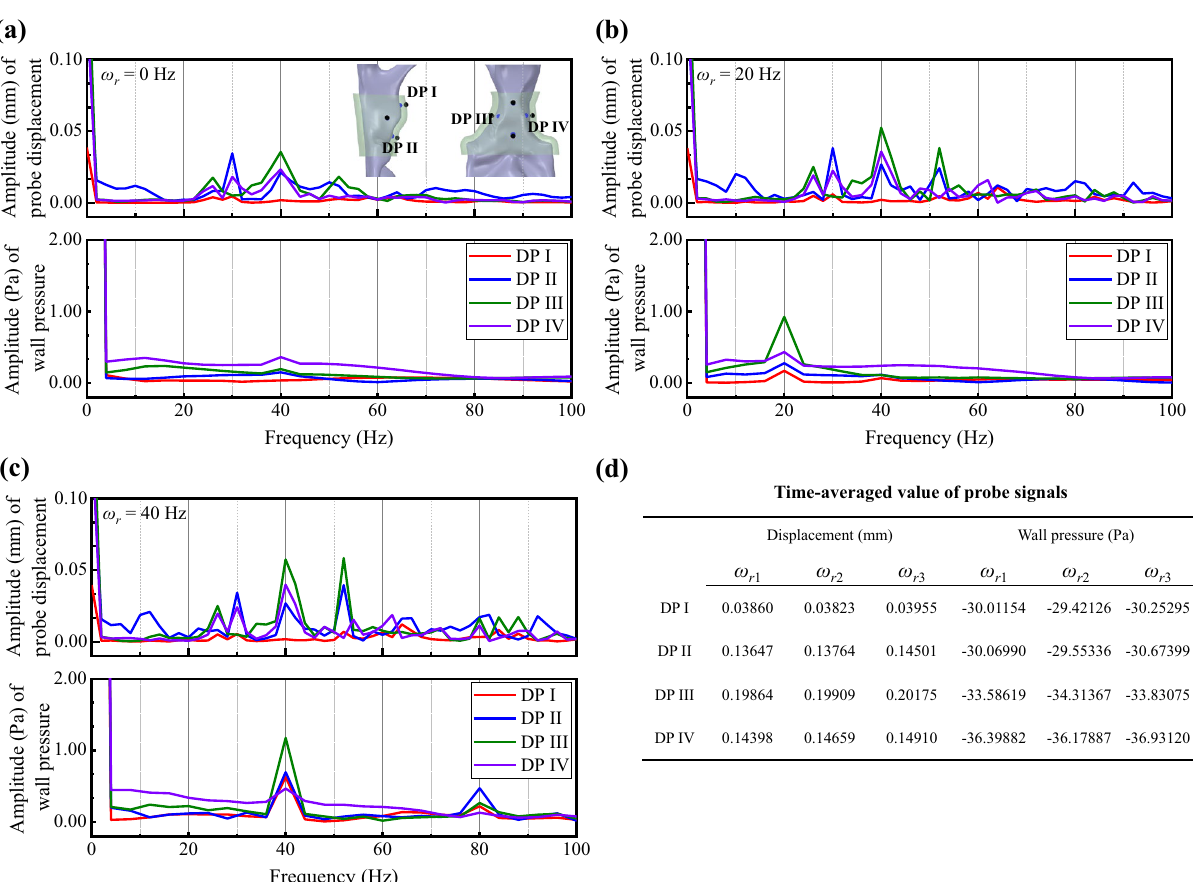
Figure 4. ( a – c ) FFT analyses displacement signals from displacement probes (DP I–IV) at three flapping frequencies. Extra one-way FSI simulations were performed to obtain the probe wall pressure close to DPs. The probes for displacement and pressure signals were shown as black points and blue points in ( a ), respectively. The displacement signals were obtained every 5e −4 s, and the wall pressure signals were obtained every 1e −5 s, which both have sufficient precision over the frequency range of concern. ( d ) The time-averaged value of probe displacement and probe pressure.